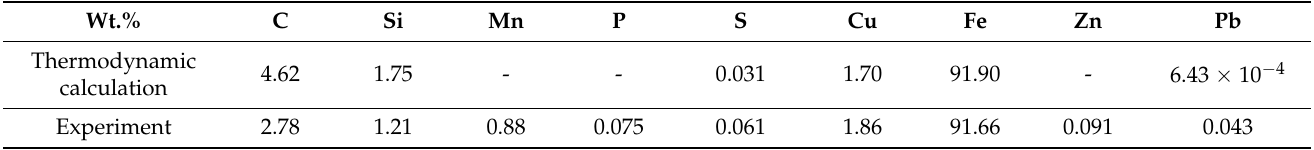
Table 3. The composition of copper – iron.